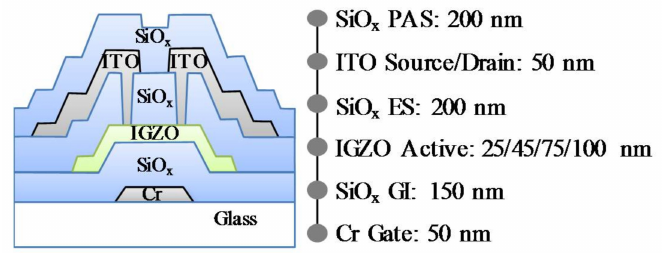
Figure 1. A schematic cross-sectional view and fabrication process of the bottom-gate indium gallium zinc oxide (IGZO) thin-film transistor